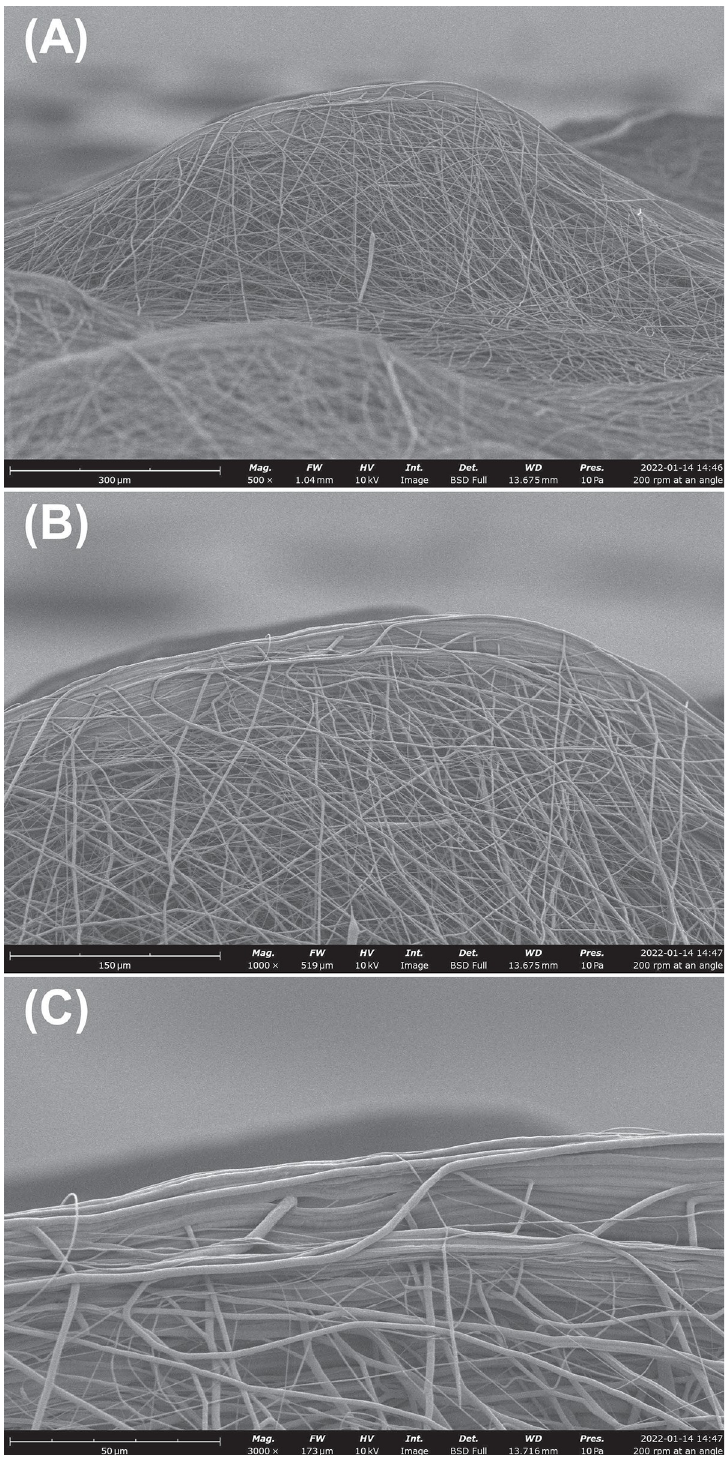
Fig 3. SEM images of surface protrusions found following 200 RPM depositions. (A) Low magnification showing the preponderance of these protrusions and their frequency. (B, C) Higher resolution images revealing the aligned fiber arches found at the ‘peak’ of these features. Images are taken at a ~90˚